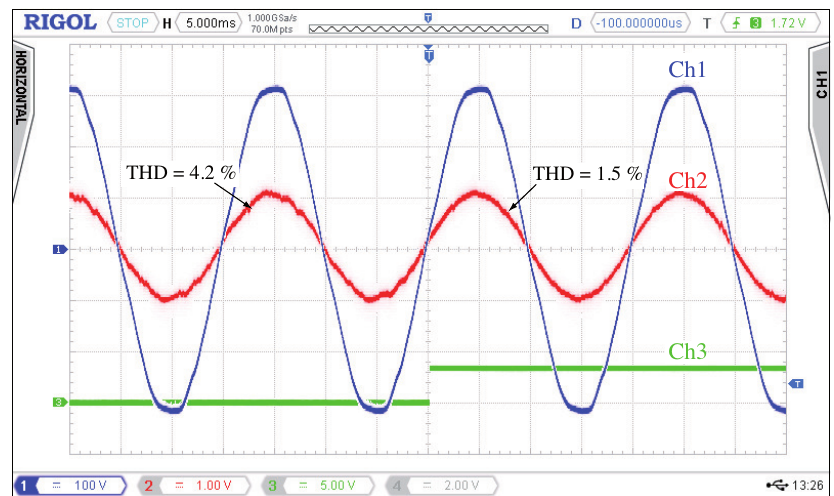
Figure 14. Capacitive Emulation (CE) activation-deactivation with the CCF scheme and PI control with grid-voltage feedforward cancellation at half nominal power. Ch1: grid voltage (100 V/div). Ch2: grid current (10 A/div). Ch3: CE on/off signal (0 = off, 1 = on).